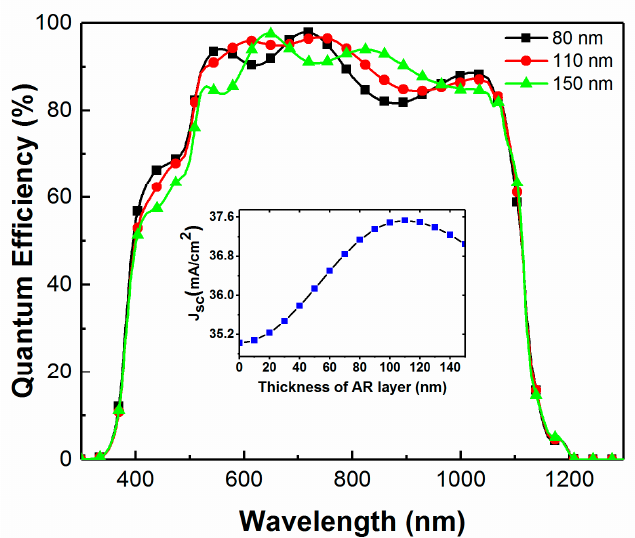
Figure 3. Simulated external quantum efficiency (QE) and short-circuit current density (J SC ) from TMT models for various thickness of the AR layer for the CIGS solar cell characterized by SE (Figure 1).